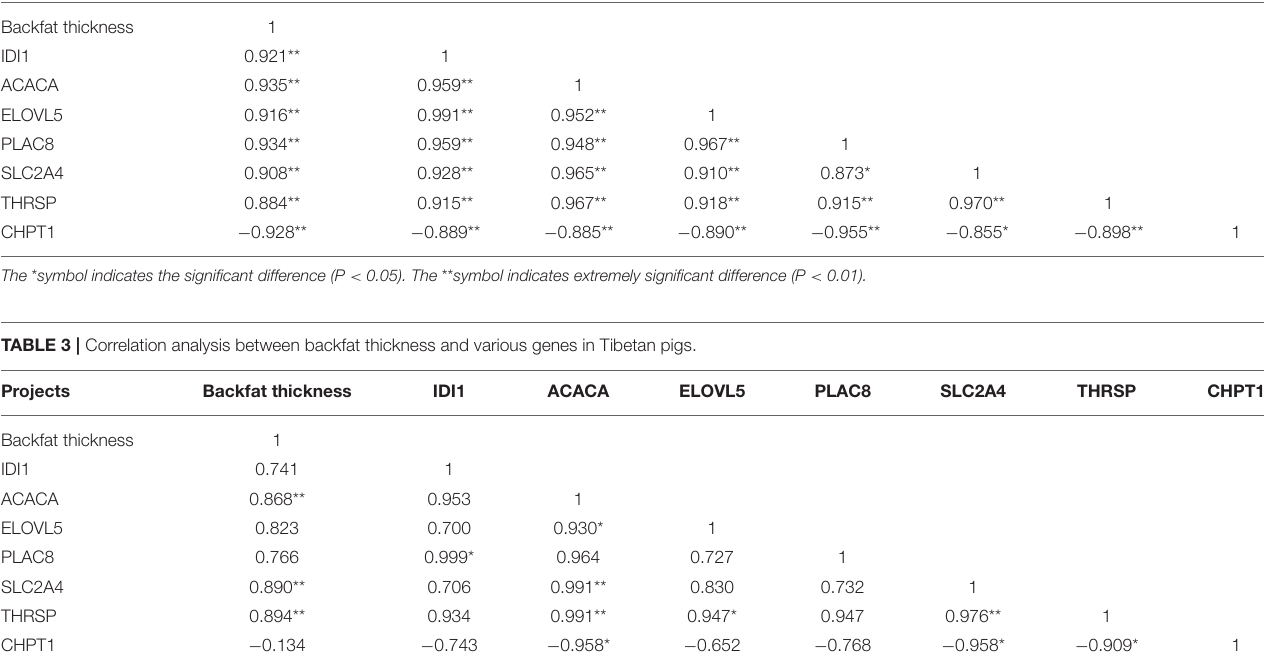
TABLE 2 | Correlation analysis between backfat thickness and various genes in York pigs. Projects